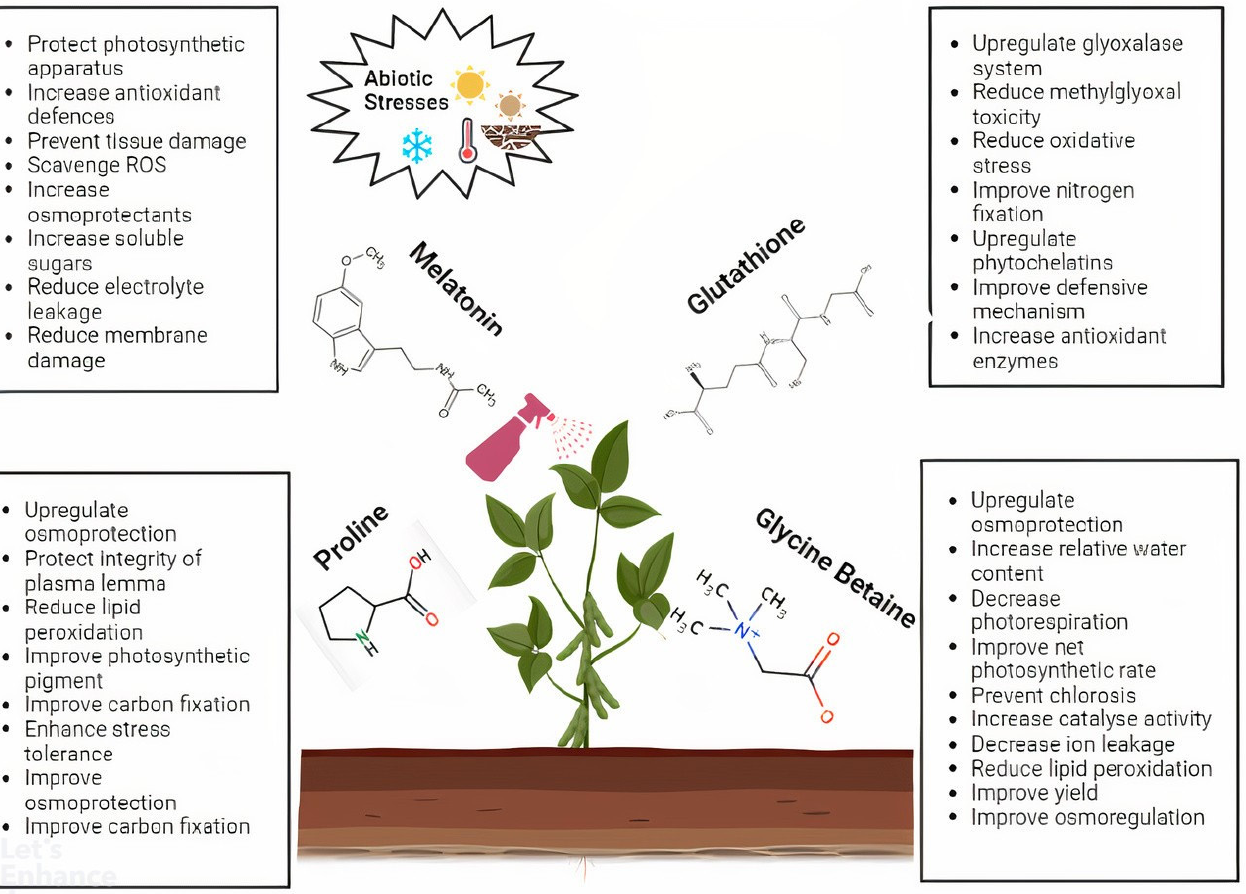
Figure 2. The external application of melatonin, glutathione, proline, and glycine betaine, along with their contribution for increasing the plant’s ability to withstand abiotic